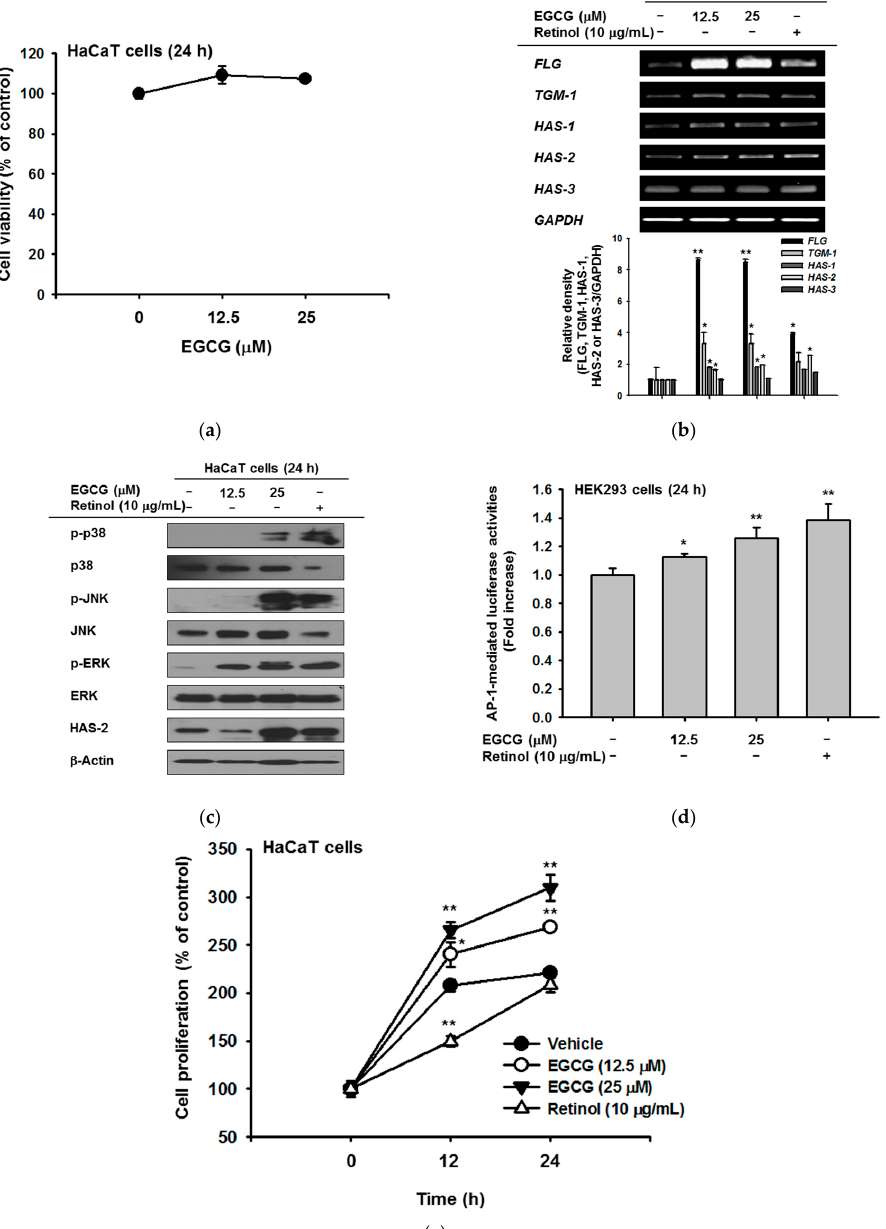
Figure 1. Effect of epigallocatechin gallate (EGCG) on skin hydration via natural moisturizing factors ( NMF) synthesis. ( a ) the viability of EGCG–treated HaCaT cells was measured by 3-(4,5-dimethylthiazol-2-yl)-2,5-diphenyltetrazolium bromide (MTT) assay; ( b ) expression of NMF